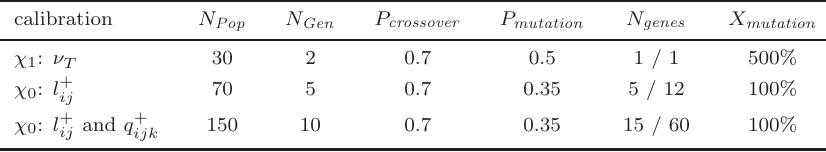
Table 1. Parameters of three-equation model calibration.